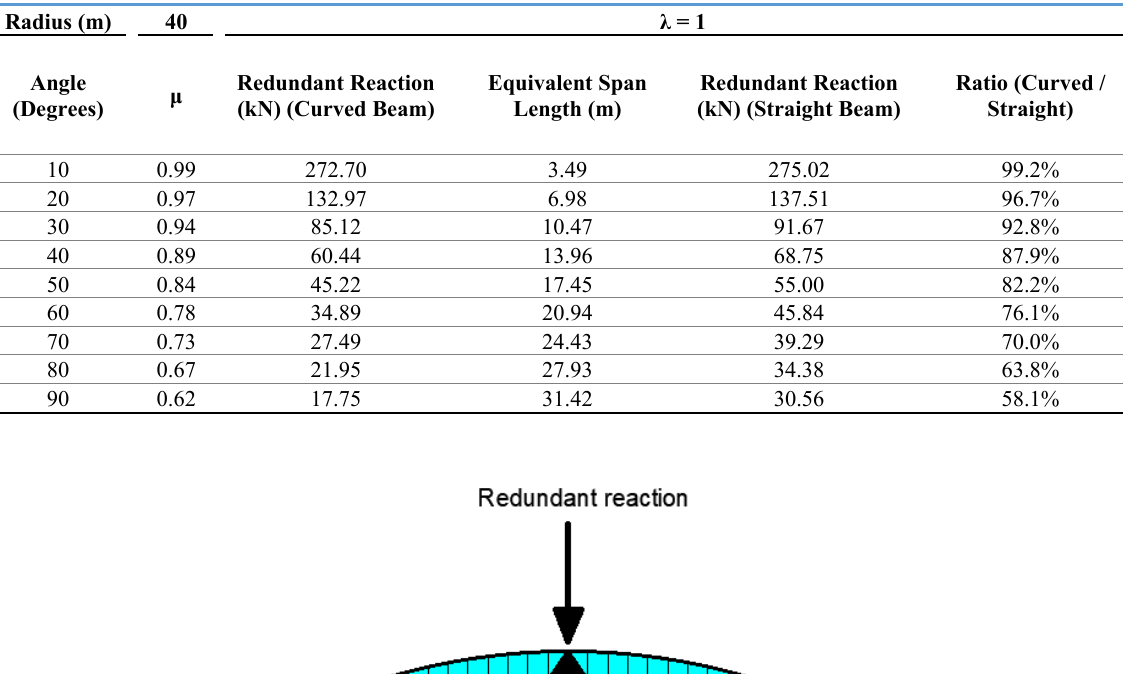
Table 1. Two-span curved continuous beam subjected to centered prestressing (